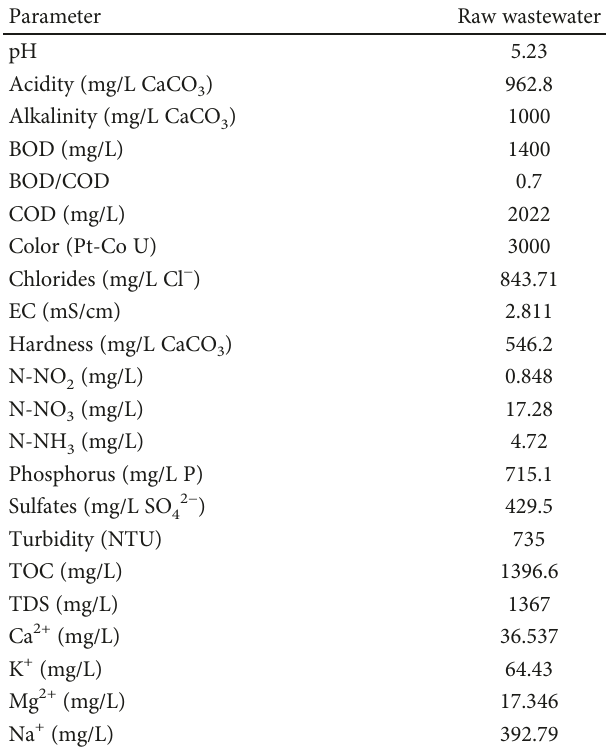
Table 3: Physicochemical characterization of textile